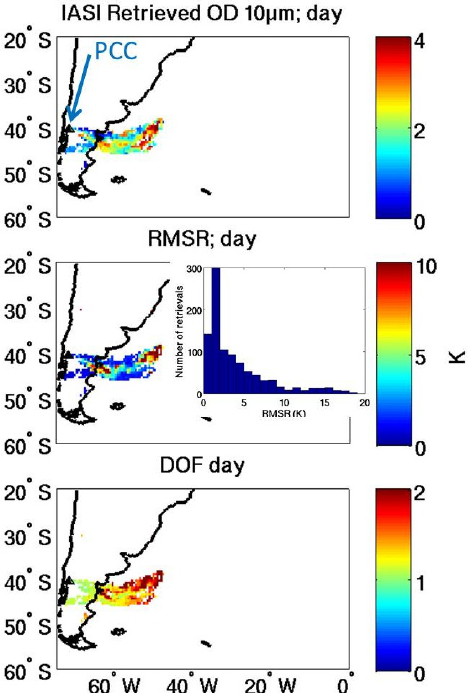
Figure 6. Retrieval results for 5 June 2011, local morning overpass. The plots show the retrieved ash aerosol optical depth (AOD) at 10 µ m, the root mean square of the residuals (RMSR) in brightness temperature (BT) units (K) and the number of degrees of freedom (DOF). White spaces are locations where our ash pre-filter was not triggered; no retrieval was therefore undertaken. The black triangle represents the volcano (in the first panel, we have added an arrow pointing to that location, labeled PCC as the initials of the Puyehue Cordón Caulle). An insert in the RMSR plot shows a histogram of the